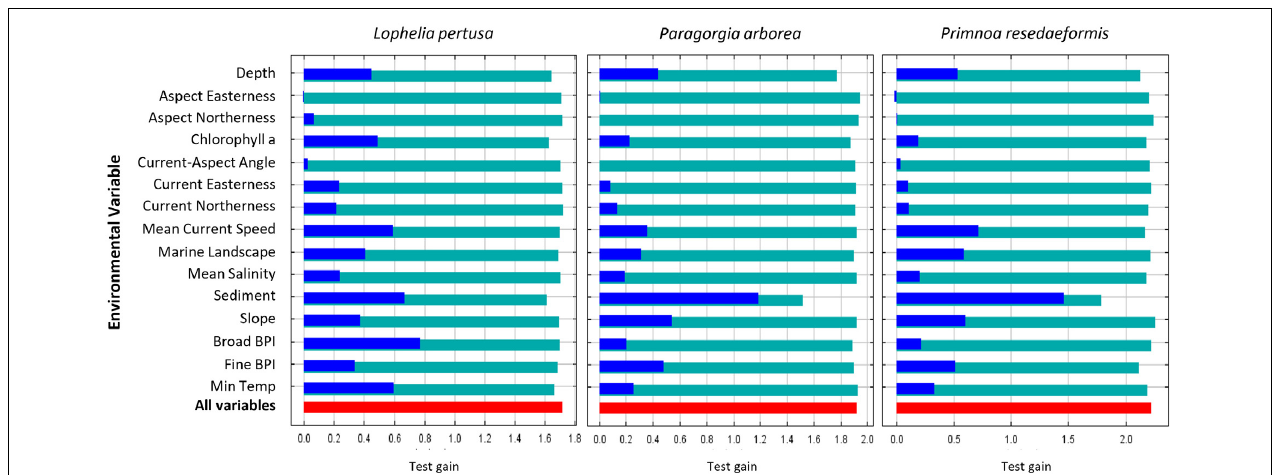
FIGURE 7 | Average Jackknife test gain results from the 10 cross-validation Model 2 runs per species. Red bars indicate the average overall test gain, teal bars the test gain result when one variable is omitted, and blue bars the test gain result when only one variable is used in a model run.